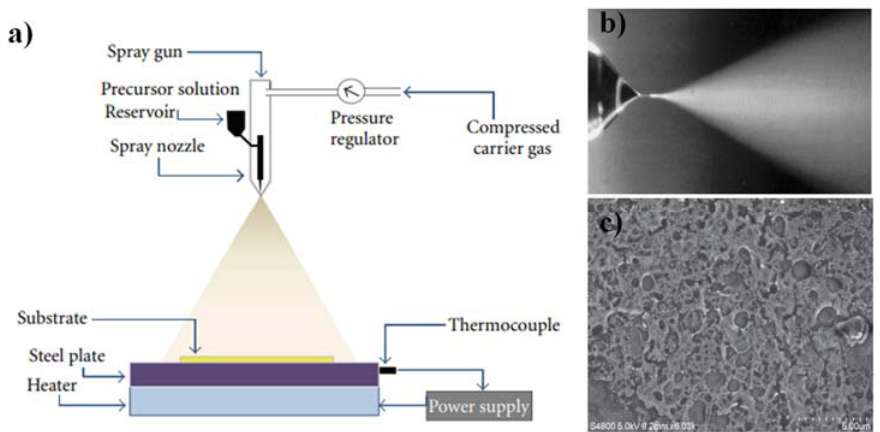
Figure 3. ( a ) The schematic of the spray pyrolysis setup [99], ( b ) Cone-jet spraying of methanol containing a small amount of HCL. Reprinted with permission from [110], ( c ) FESEM micrograph of SnO 2 thin film [99].